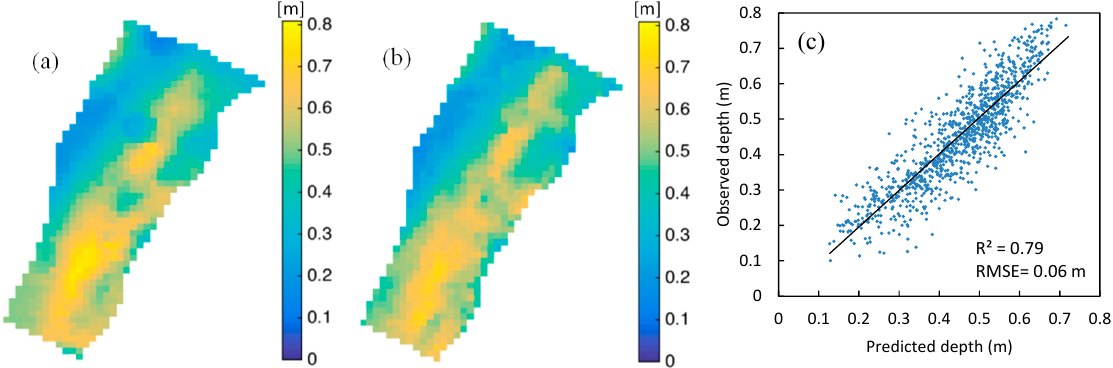
Figure 15. ( a ) In-situ depths compared to ( b ) MODPA-derived depth map of the Sarca River and ( c ) match-up validation.